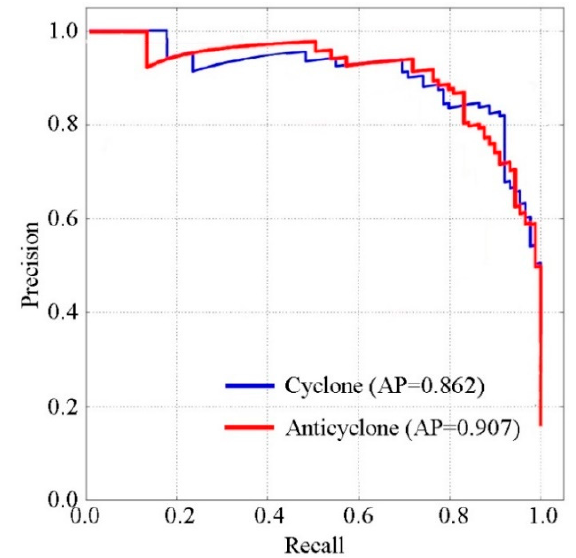
Figure 6. Precision-recall (PR) curve of cyclone and anticyclone identification. Table 2. Performance measurements for cyclones detection results using two different methods.